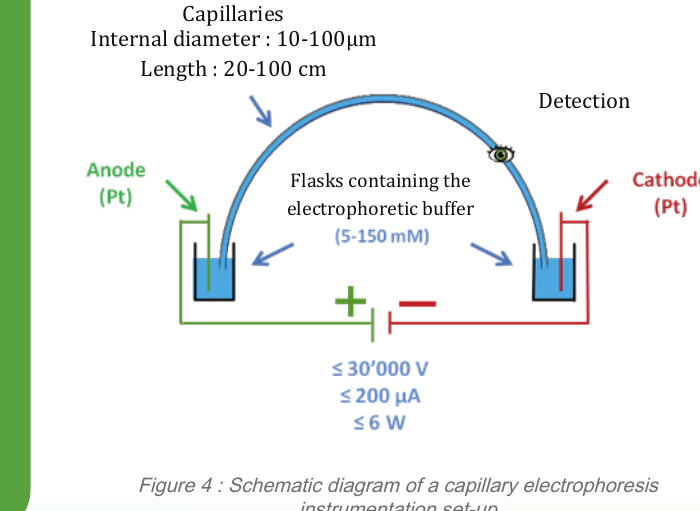
Figure 4 : Schematic diagram of a capillary electrophoresis instrumentation set-up